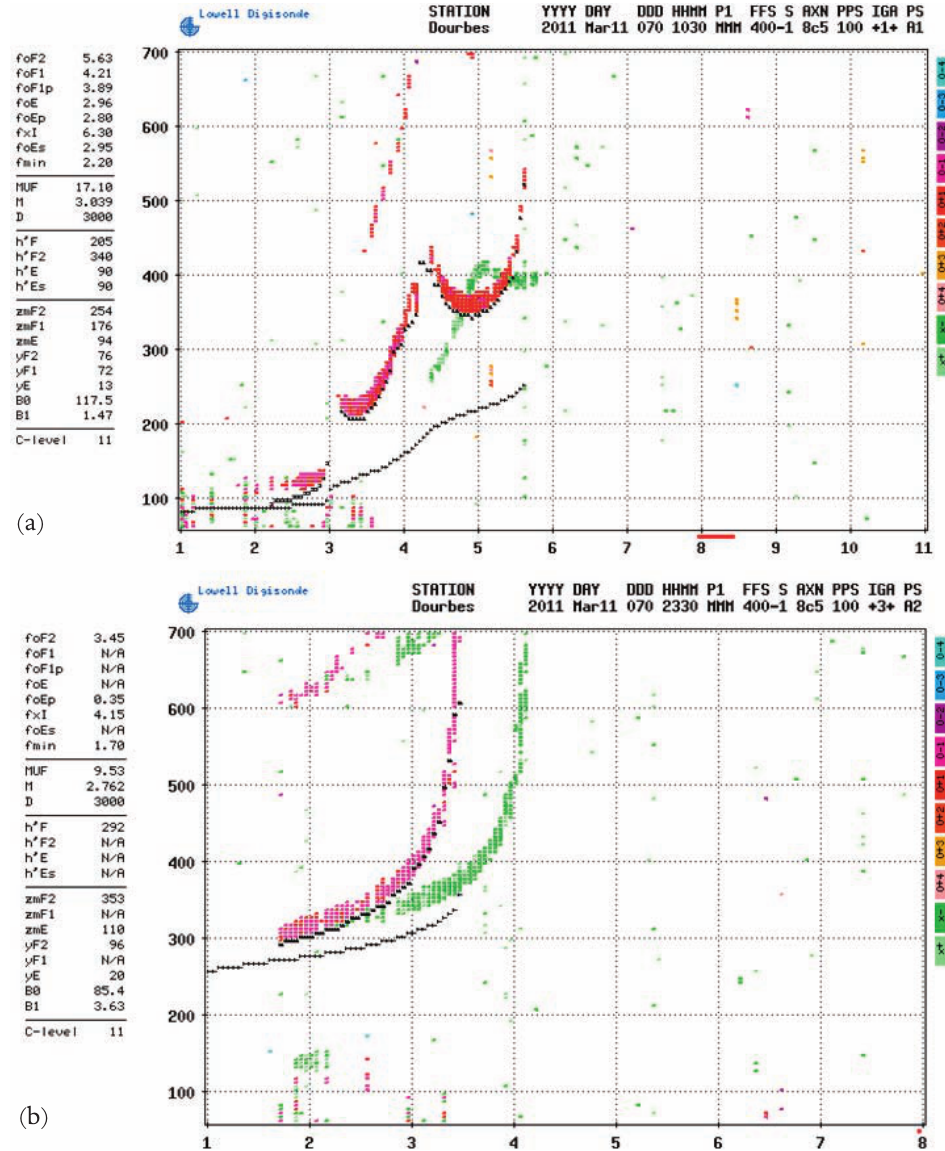
Figure 1. Real-time autoscaled ionograms from